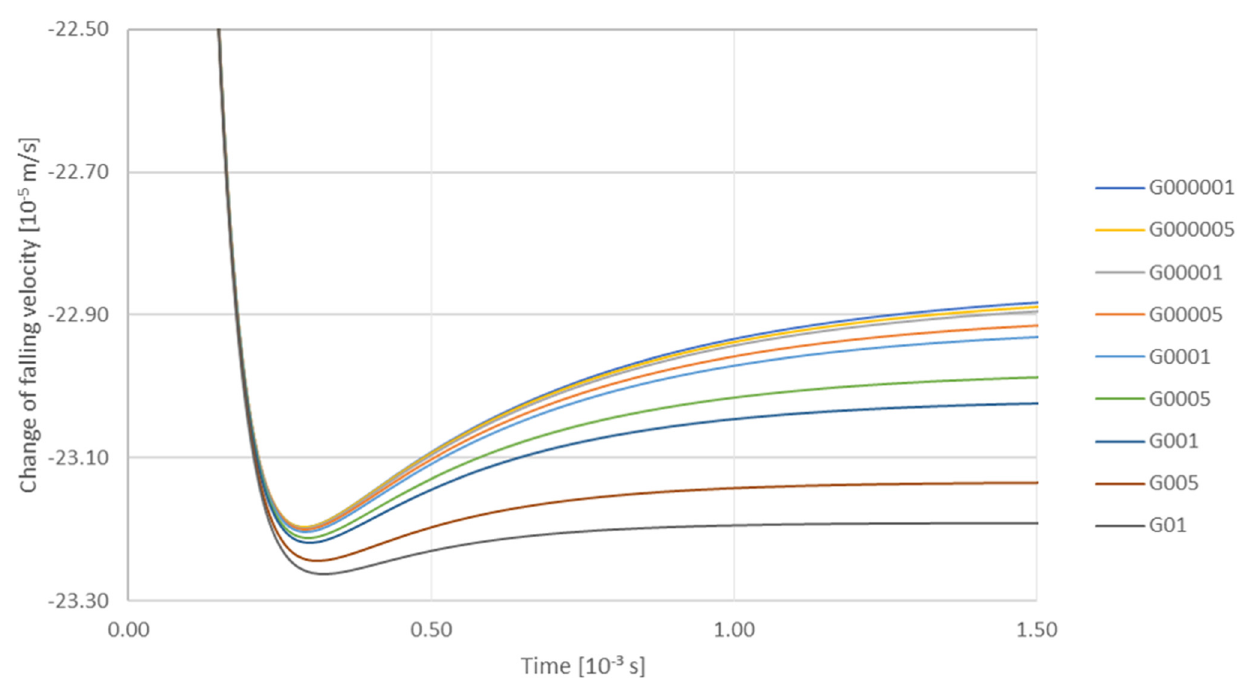
Figure 11. Analysis of the influence of gradient on the change of falling velocity of a TiC particle with a radius of 7.75 × 10 − 8 m under the viscosity conditions of 0.0015 Pa · s. Gradient, m/s: G000001—0.00001; G000005—0.00005; G00001—0.0001; G00005—0.0005; G0001—0.001; G0005—0.005; G001—0.01; G005—0.05; G01—0.1.